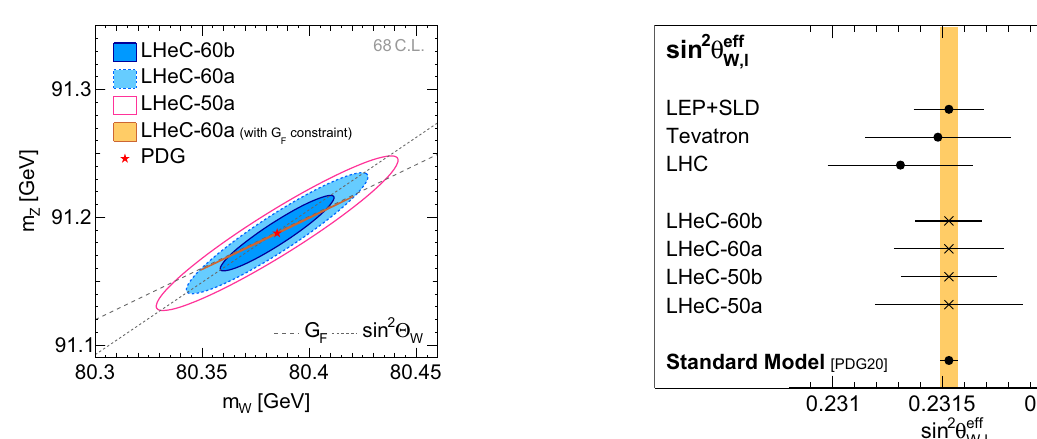
Fig. 5 Simultaneous determination of the Z -boson and W -boson masses m Z and m W from LHeC-60a or LHeC-50a data. The additional precision measurement of G F yields a strong constraint and its com- bination with the m Z and m W determination leads to a very shallow ellipse